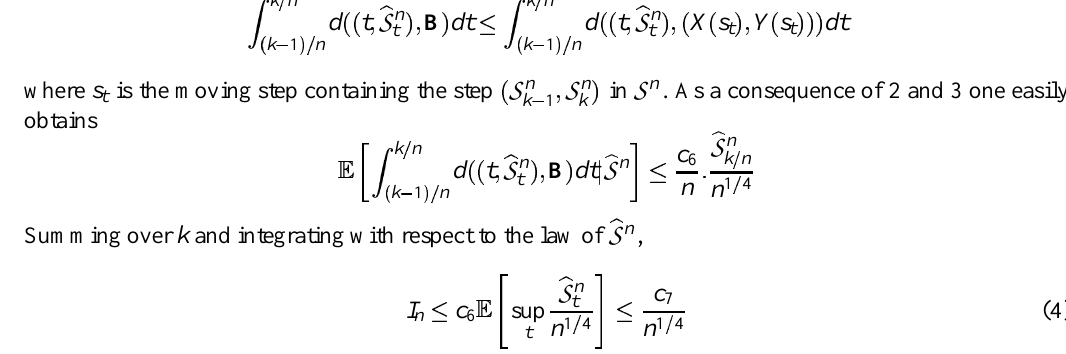
table number i , 1